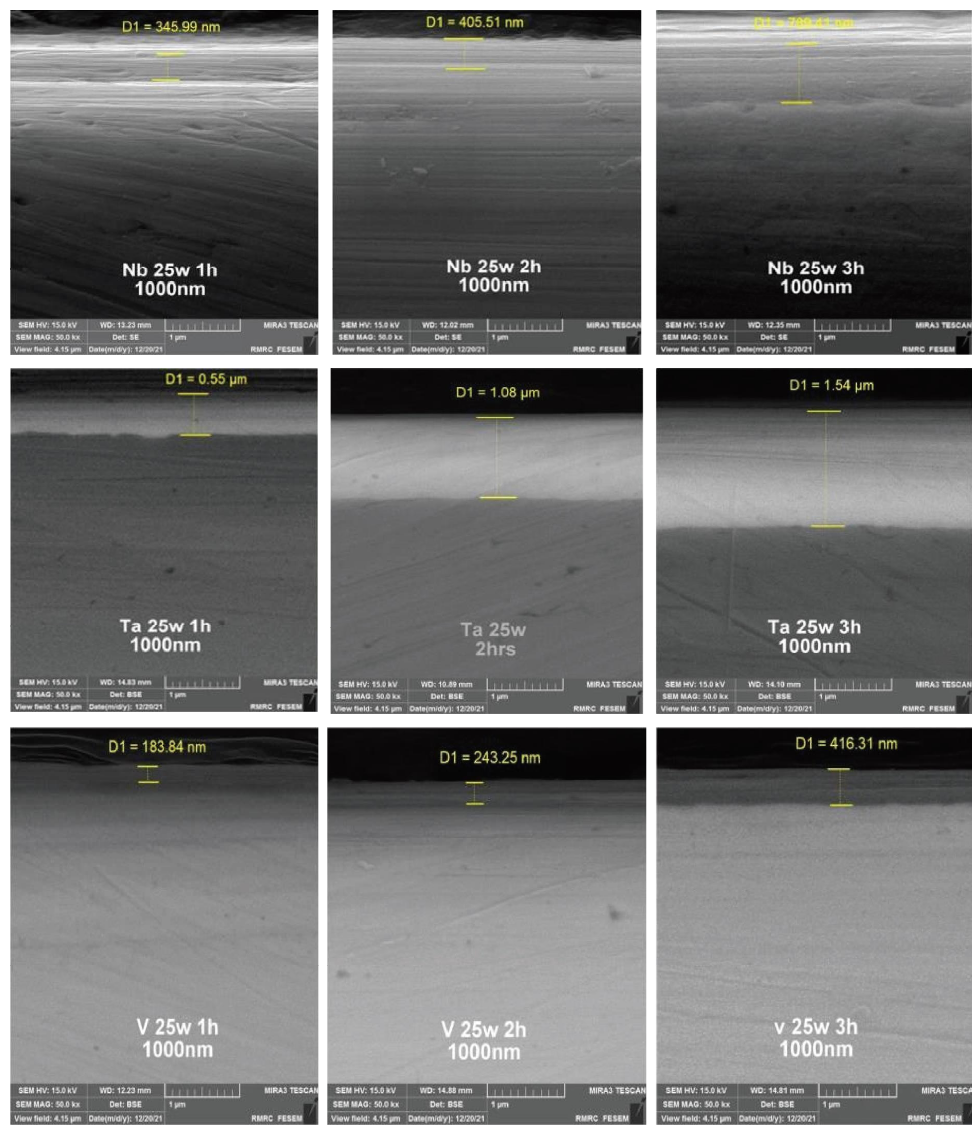
Figure 6: Tickness of Nb, Ta, and V nanocoating layers of plasma-sputtered 316L SS substrates (1 st readings at 1, 2, and 3hours). Table 4: Elemental composition (wt.%) of coated Nb, Ta, and V at diferent sputtering times using EDS.